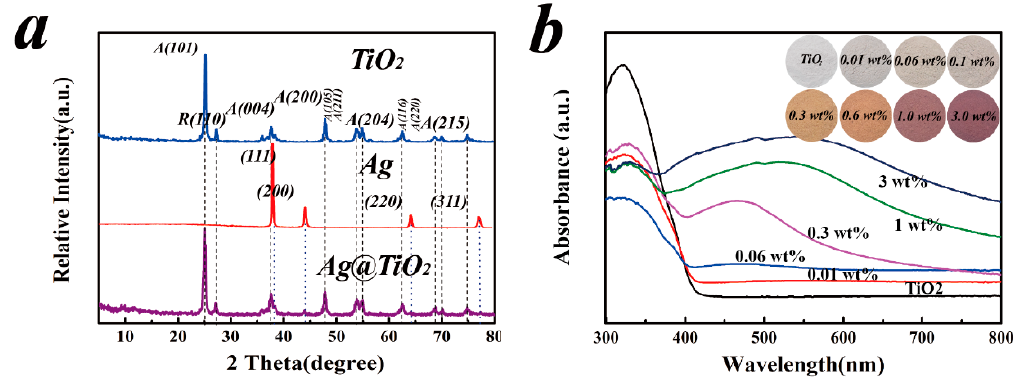
Figure 3. ( a ) XRD patterns of the Ag@TiO 2 photocatalysts, in which A is anatase phase and R is rutile phase (no obvious Ag characteristic peak was found due to the ultra-trace loaded amount); ( b ) UV-vis diffuse spectra of Ag@TiO 2 in different doping ratio (dried sample images with different Ag loadings, insert).